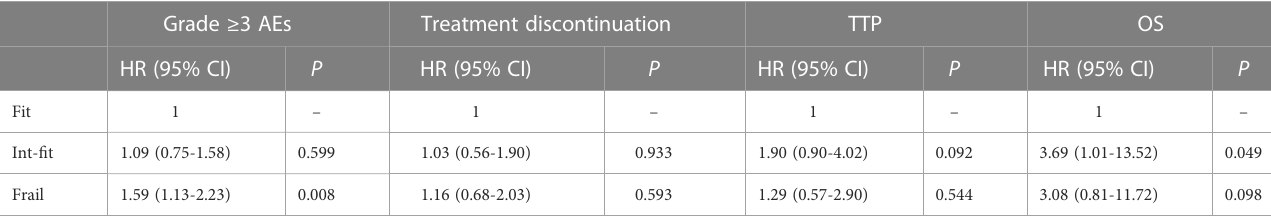
TABLE 2 Multivariate analysis of the impact of the IMWG GA results on the incidence of grade ≥ 3 AEs, treatment discontinuation, TTP, and